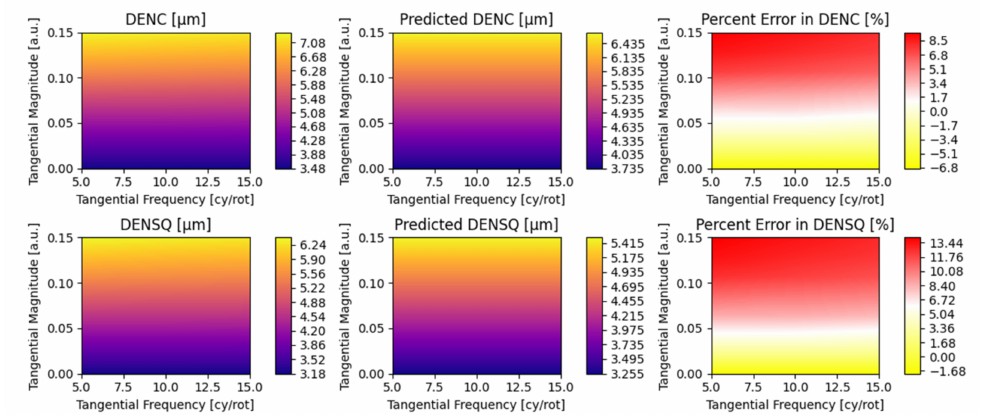
Figure A20. Tangential Frequency vs. tangential magnitude. ( η = ζ = δ = 0, ξ = 15, σ = 0.05, θ = 45 ◦